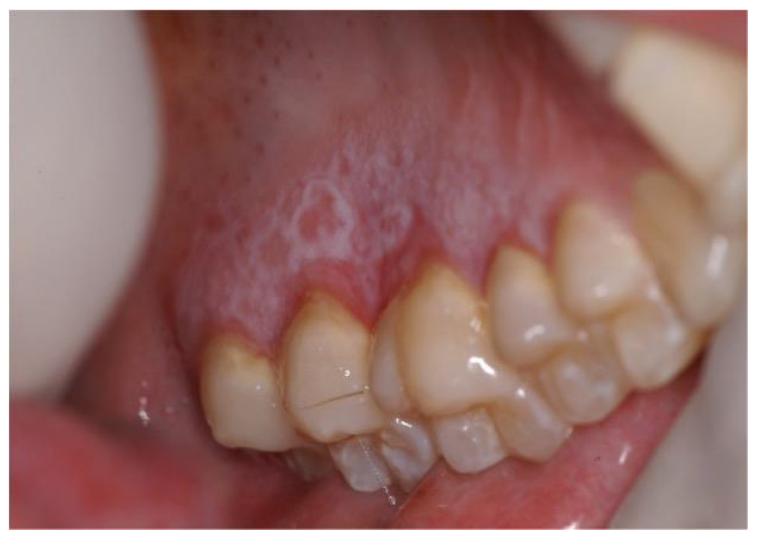
Figure 2. Patient affected by oral cGVHD showing keratotic lesions with papular pattern and tendency to the reticular pattern in the palatal area. There is also a paramarginal gingival